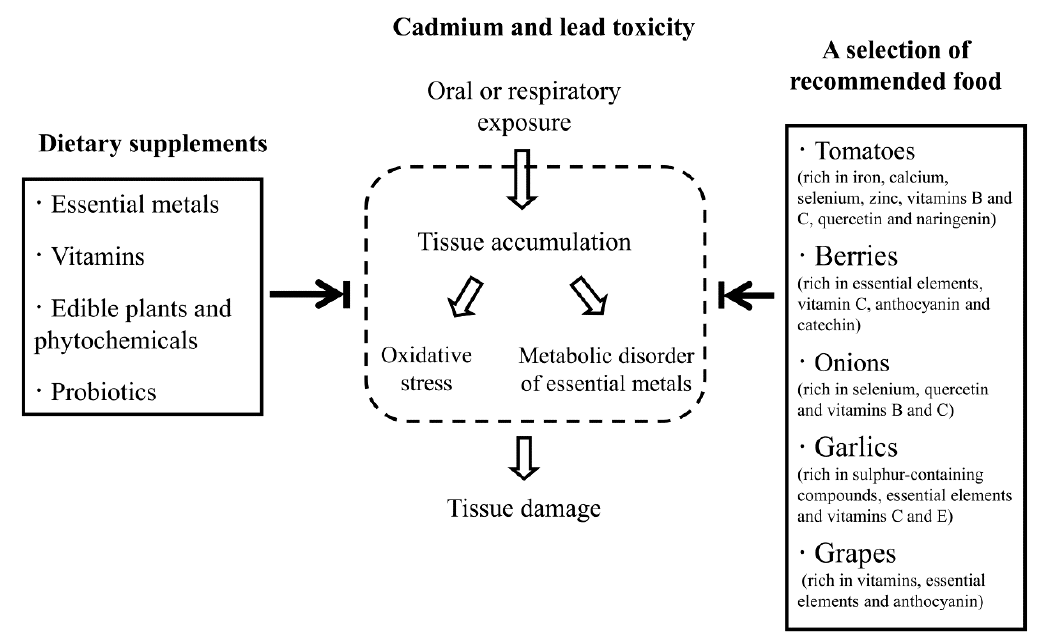
Figure 1. Dietary supplements and recommended strategy against cadmium and lead